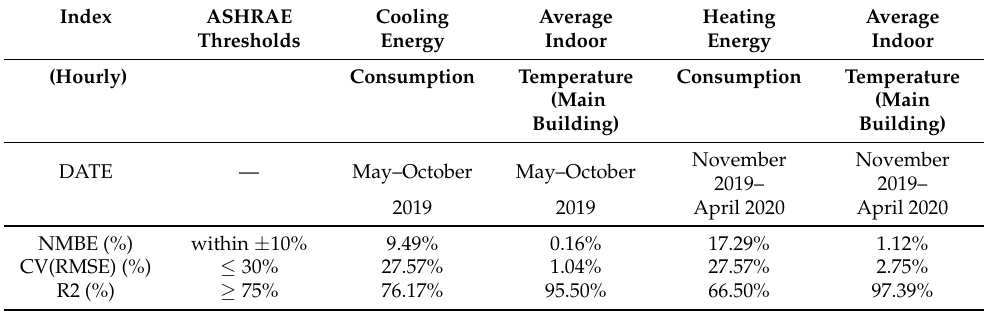
Table A7. Results of VRV system calibration for cooling and heating periods, 2019–2020.